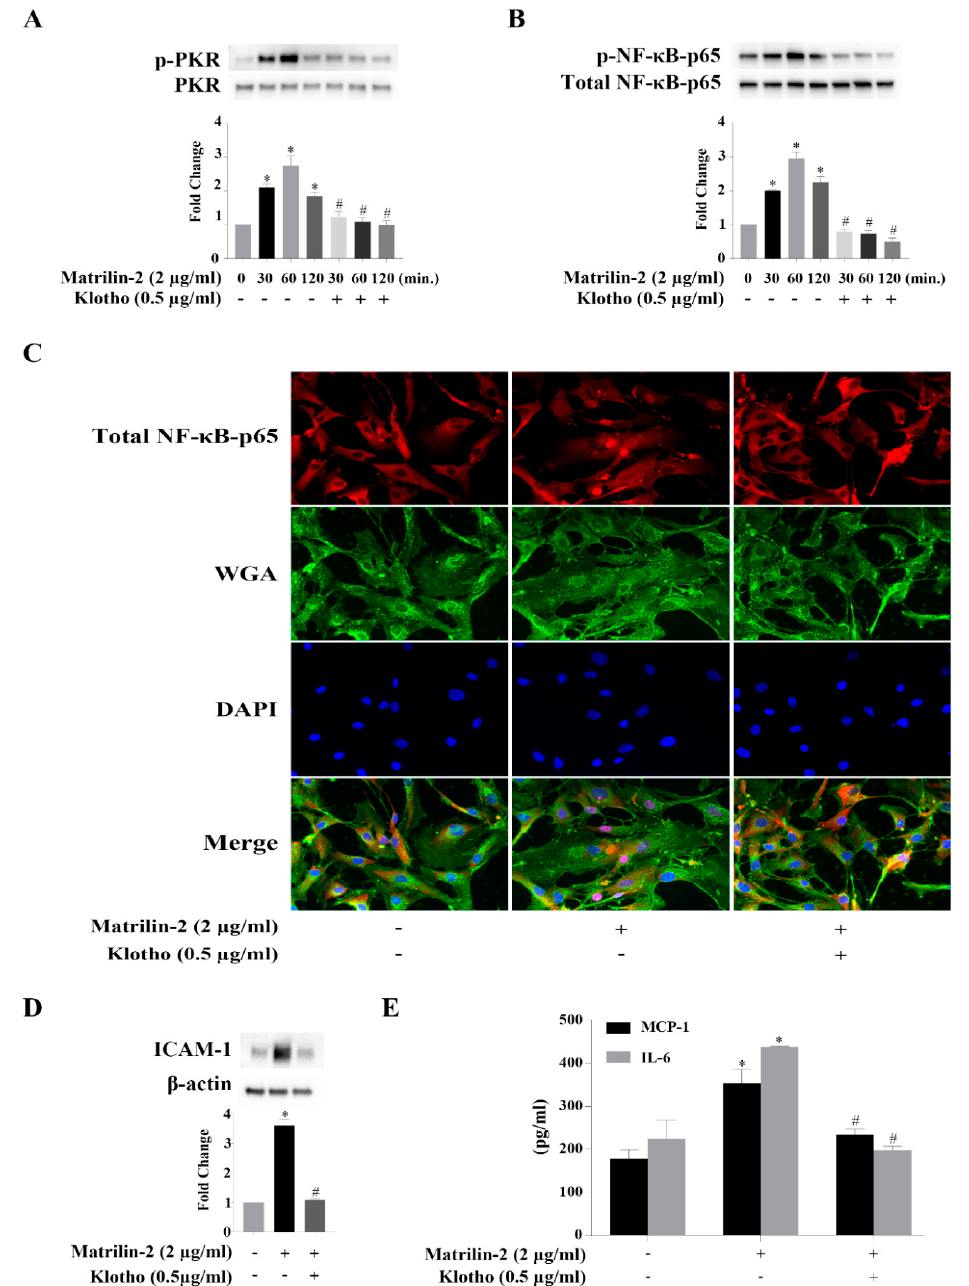
Figure 6. Klotho suppresses matrilin-2-induced inflammatory responses in human AVICs via inhibition of the PKR-NF- κ B cascade. Human AVICs were treated with recombinant Klotho (0.5 µ g / mL) for 2 h or left untreated, followed by stimulation with matrilin-2. ( A ) Recombinant Klotho suppressed matrilin-2-induced PKR activation. ( B ) Recombinant Klotho attenuated soluble matrilin-2-induced NF- κ B activation. Values are means ± SE. n = 3 separate experiment; * P < 0.05 vs. control; # P < 0.05 vs. the same time point of matrilin-2 alone. ( C ) Klotho inhibited matrilin -2 -induced NF- κ B nuclear translocation. Representative images of immunofluorescence staining show NF- κ B (red) in human AVICs. Alexa 488-tagged WGA (green) was applied to outline plasma membrane. DAPI (blue) was applied for nuclear counterstaining. Original magnification, × 40 objective. ( D ) Klotho attenuated matrilin-2-induced ICAM-1 expression. ( E ) Klotho reduced MCP-1 and IL-6 production induced by matrilin-2. Values are means ± SE. n = 5 separate experiments using distinct cell isolates; * P < 0.05 vs. control; # P < 0.05 vs. matrilin-2